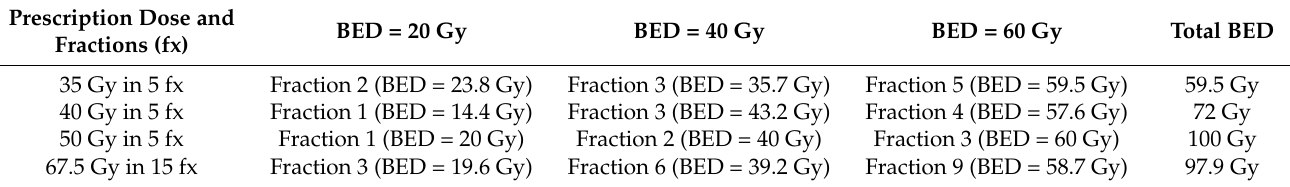
Table 1. Fractions selected to obtain equivalent biologically effective dose (BED) levels to varying of the prescription dose and fractions. Prescription Dose